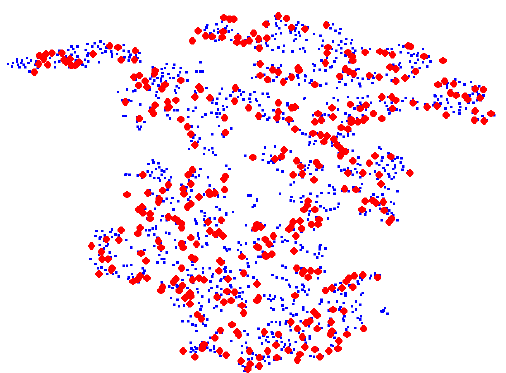
Figure 1. t-SNE [9] view of training (blue) and test (red) dataset from a retrained GoogLeNet [4]. Different categories are mixed together after